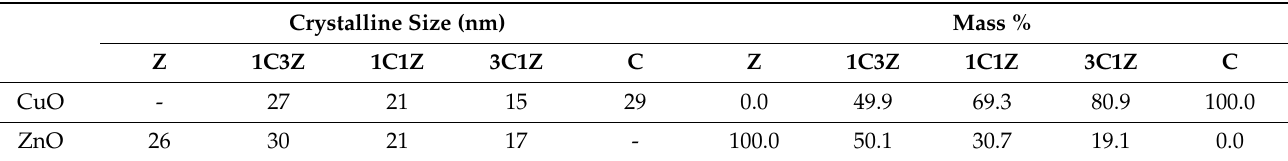
Table 2. The crystalline size (nm) of CuO and ZnO was estimated by the Debye–Scherrer formula, and the composition of each nanocomposite was obtained from AAS